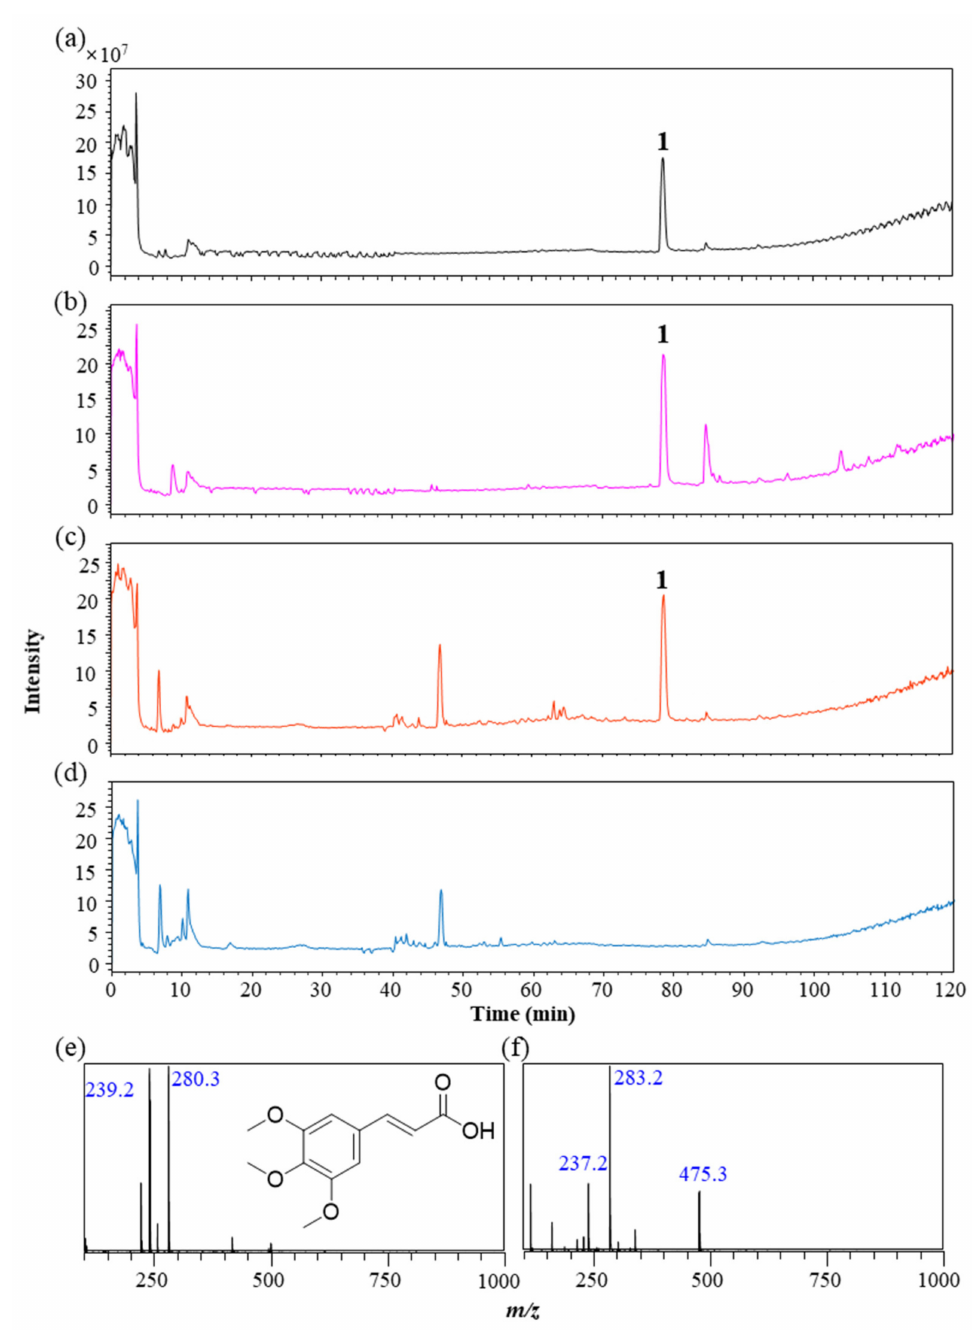
Figure 4. Identification of main compounds in three I. indigotica leaf fractions using LC-MS. Total ion chromatograms of ( a ) standard of 3,4,5-trimethoxycinnamic acid, ( b ) fraction 1, ( c ) fraction 2, and ( d ) fraction 3 at positive mode. MS spectra of peak 1 (3,4,5-trimethoxycinnamic acid) at ( e ) positive and ( f ) negative mode. LC conditions: column, Hector-M C18 column (4.6 mm × 250 mm, 5 m); flow rate, 0.3 mL/min; mobile phase, A-0.1% formic acid in water and B-0.1% formic acid in acetonitrile; elution program, 0% B for 20 min to 100% B 130 min; injection volume, 10 µ L. MS conditions: interface, electrospray ionization; interface voltages, 3.5 kV at positive and − 3.5 kV at negative; nebulizing gas flow rate, 3 L/min; desolvation line temperature, 250 ◦ C; drying gas flow rate, 15 L/min; heat block temperature, 400 ◦